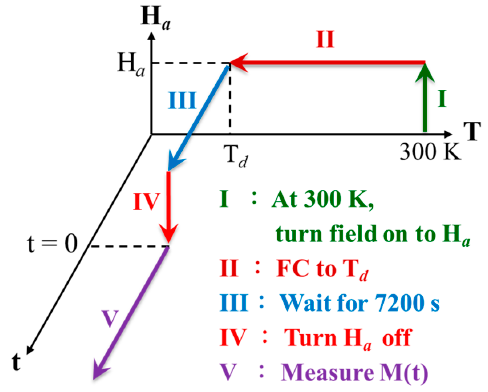
Figure 2. Schematics of the experimental processes in terms of temperature T, applied magnetic field H a , and time t in measuring the magnetic relaxation of the Faraday induced magnetization. The Roman letters and the arrows indicate the sequences of the processes.